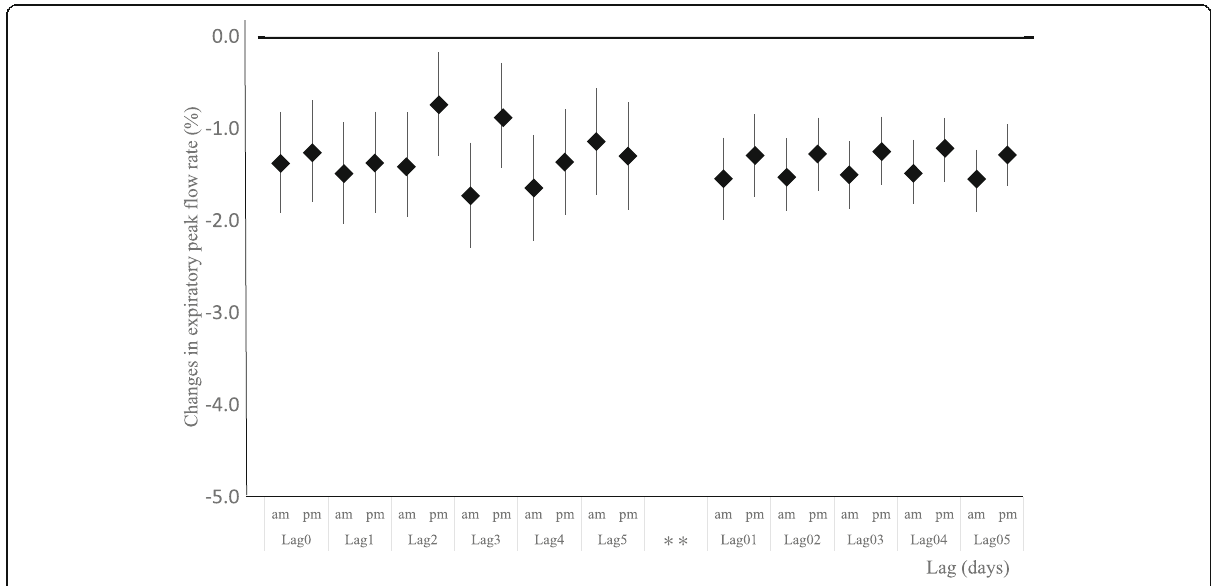
Fig. 3 Association between Asian dust exposure and changes in peak expiratory flow rate (continuous variable) using a linear mixed-effects model adjusting for age, sex, daily mean temperature, daily relative humidity, and daily concentration of Ox. Single lag effects (left) and cumulative lag effects (right). The vertical bars represent 95% confidence intervals